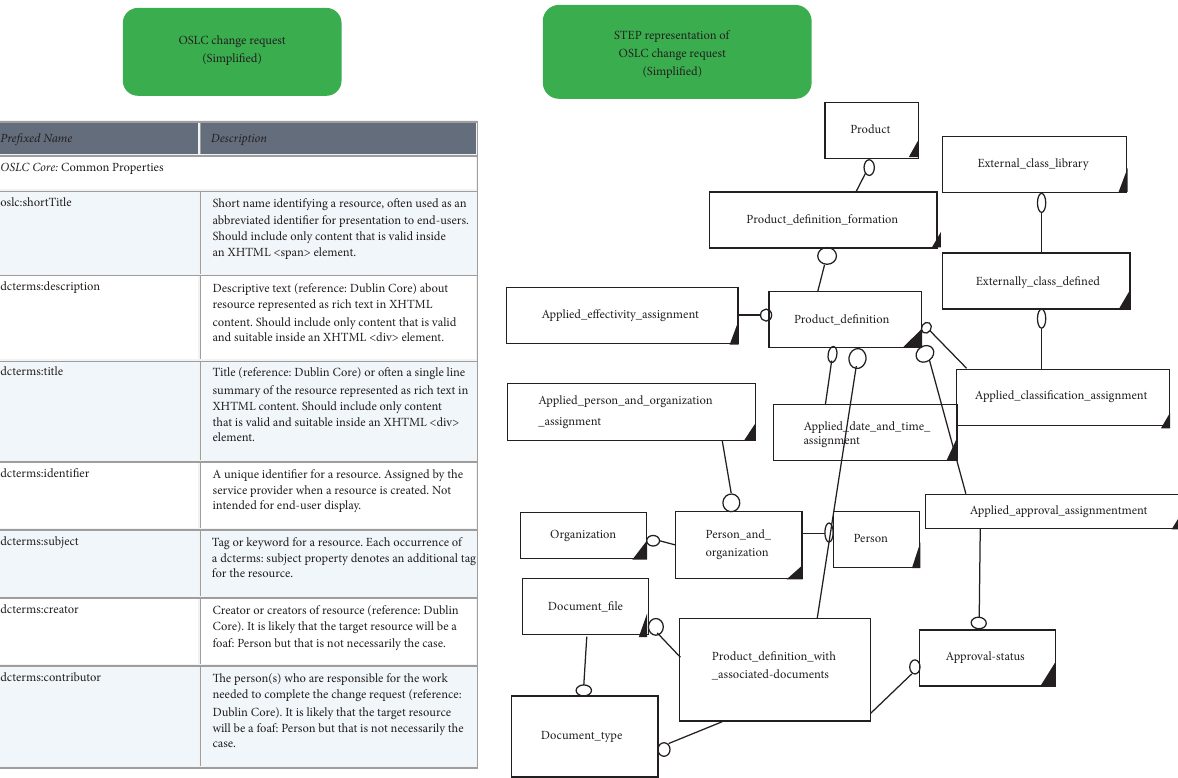
Figure 4: OSLC change request to left and product revision to the